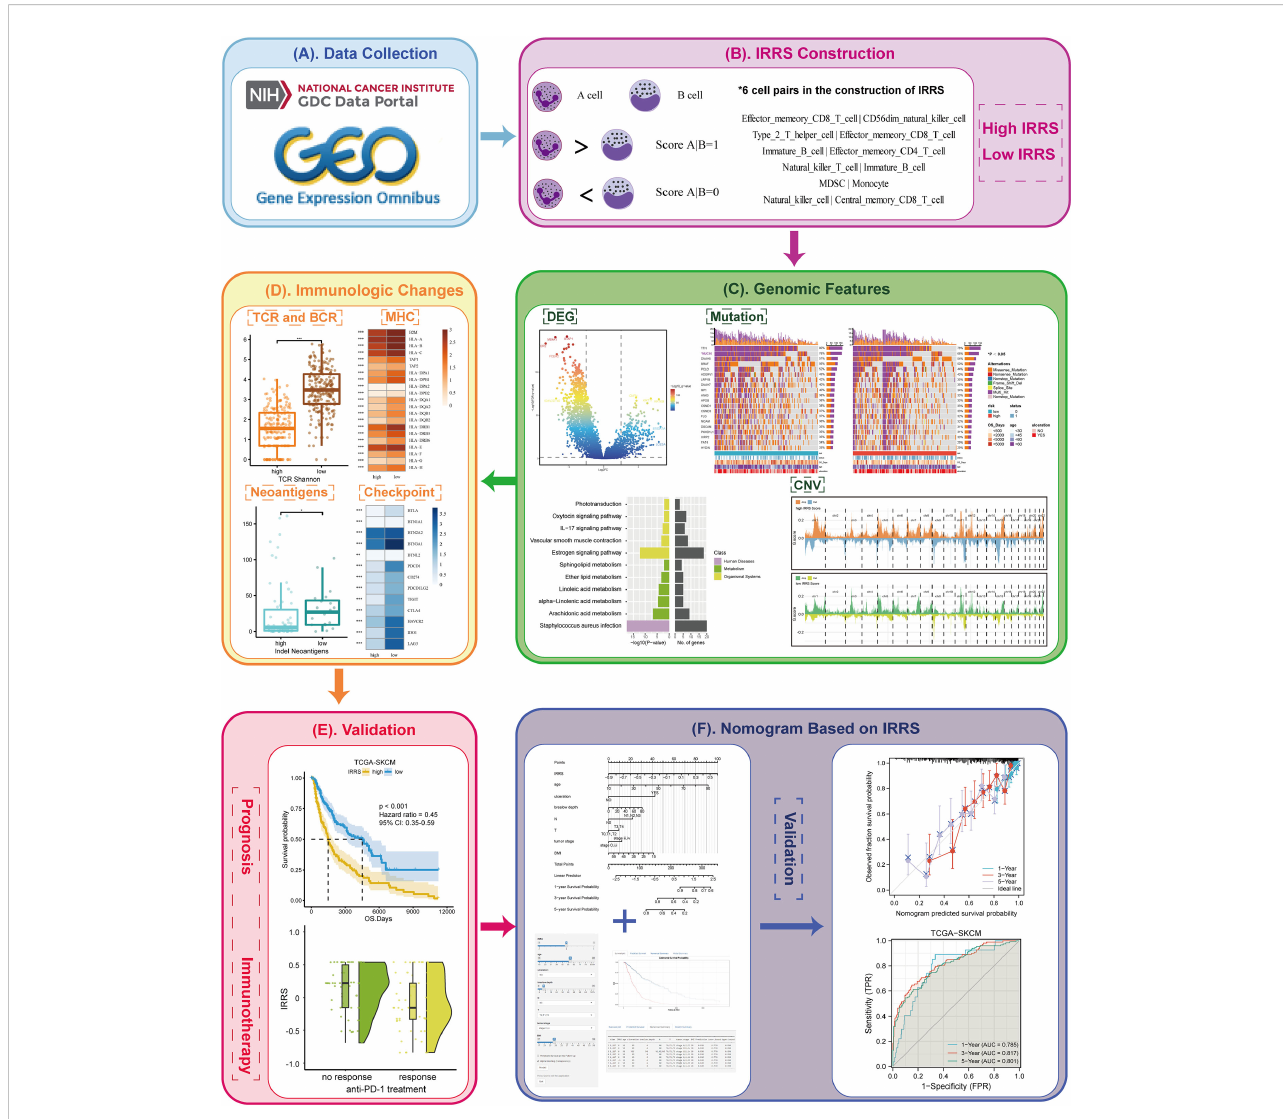
FIGURE 1 Overview of the work fl ow. (A) The data of this study were from The Cancer Genome Atlas (TCGA) and GEO cohorts. (B) The immune-related risk score (IRRS) was constructed by the relative value of cell abundance, that is, cell pairs. (C) Discovered the difference in the genomic features between the high and low IRRS through DEG, mutation, and CNV. (D) Immunologic changes based on the IRRS was analyzed by the TCR and BCR, MHC, neoantigens, and checkpoints. (E) The prognosis and immunotherapy predictive effects were con fi rmed. (F) A nomogram based on the IRRS was constructed and